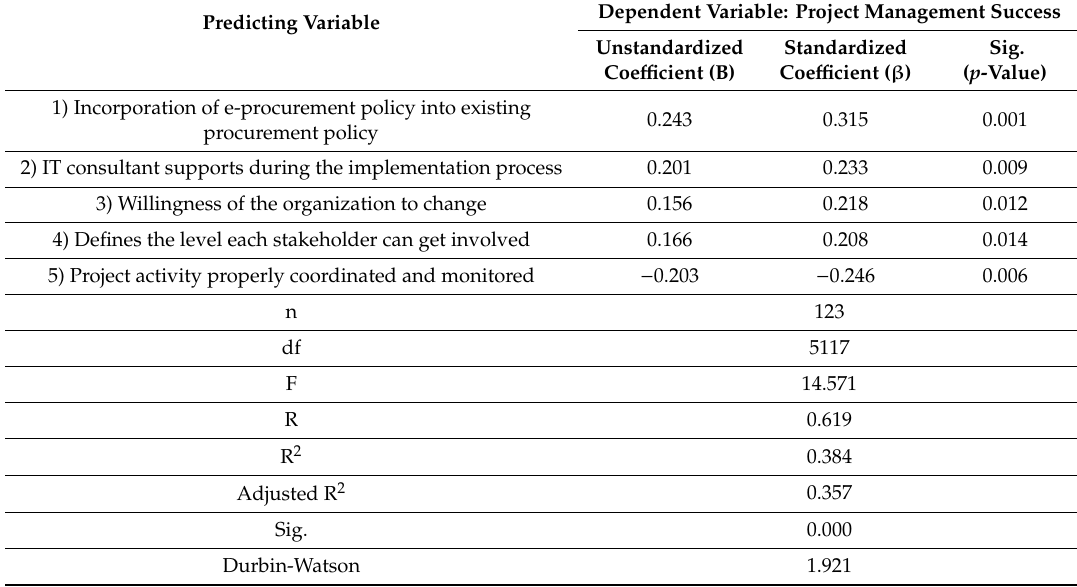
Table 2. Stepwise hierarchical regression models (project management